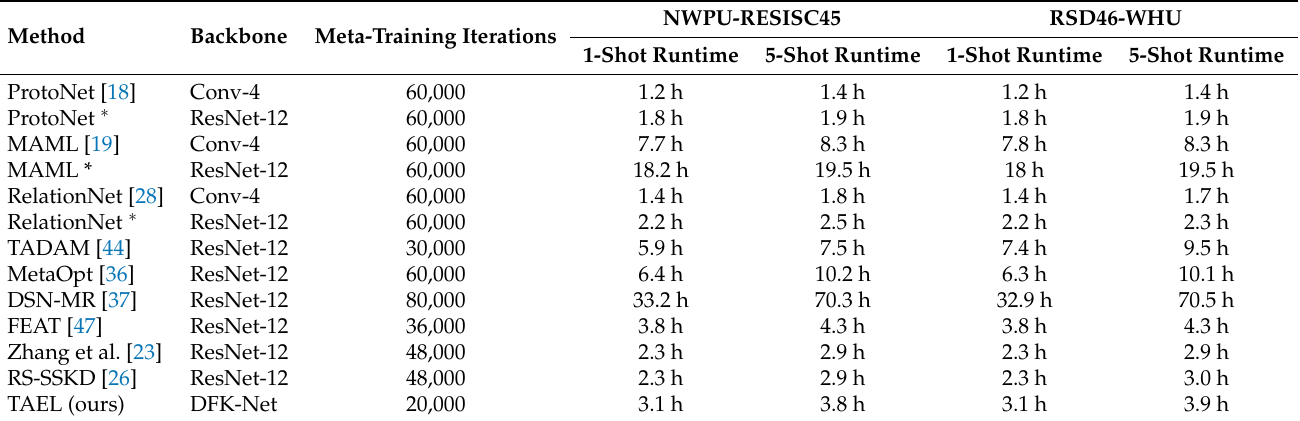
Table 10. Meta-training runtime comparison on NWPU-RESISC45 and RSD46-WHU datasets, under 5-way 1-shot and 5-way 5-shot classification